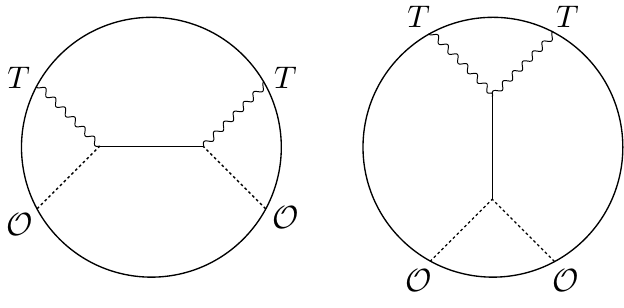
Figure 2 . s and t -channel exchange diagrams for h T OO T i ,